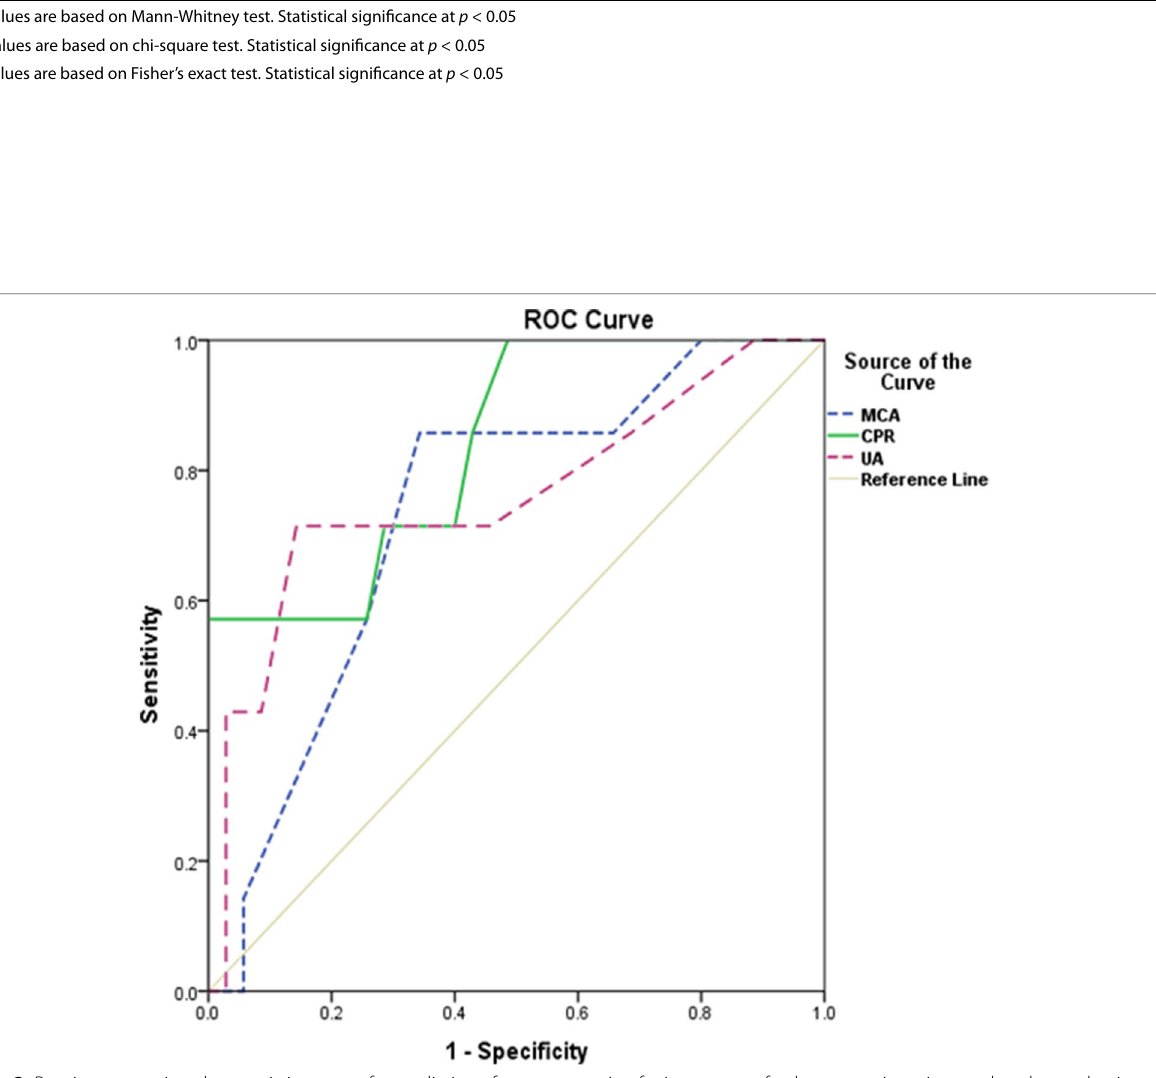
a p values are based on Mann-Whitney test. Statistical significance at p < 0.05 b p values are based on chi-square test. Statistical significance at p < 0.05 c p values are based on Fisher’s exact test. Statistical significance at p < 0.05